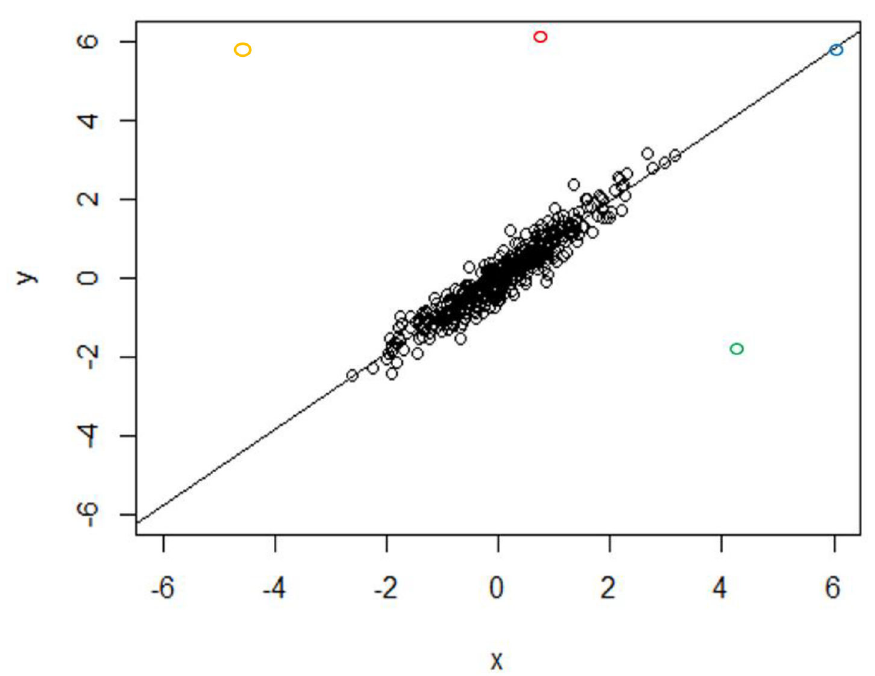
Scatterplot for 400 Simulated x-y Points With the Population Correlation of